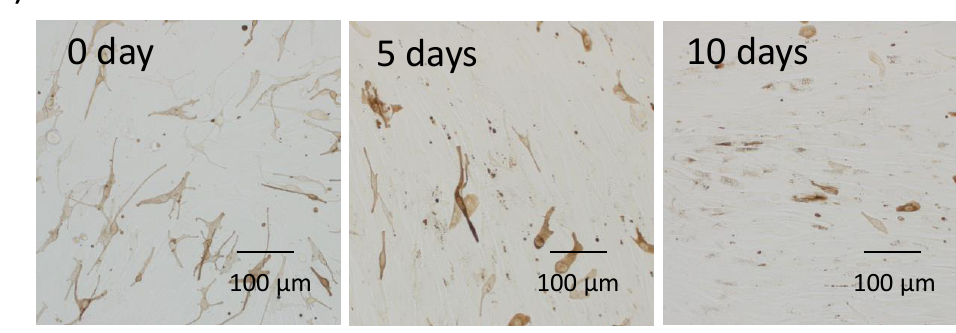
(b) Mixed Medium suitable for melanocytes and fibroblasts